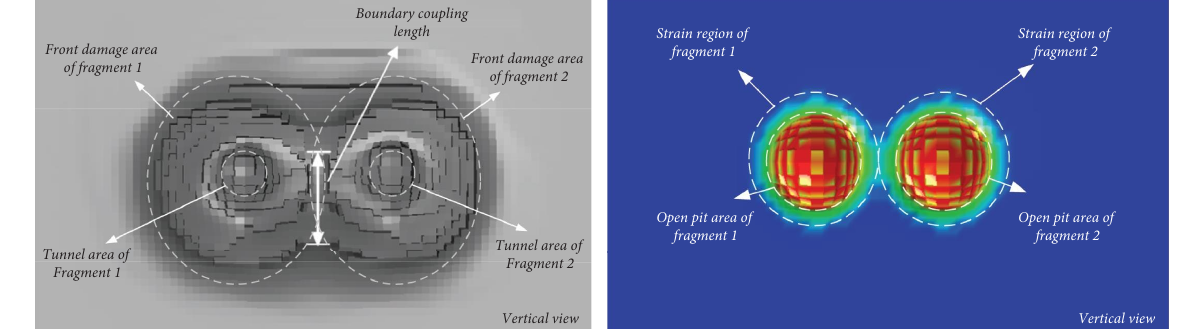
Figure 10: Surface joint length and surface joint occurrence